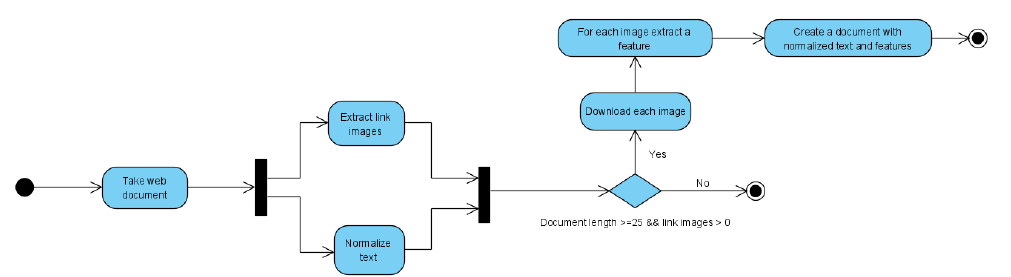
Figure 2. Activity diagram: Multimedia web Documents Repository